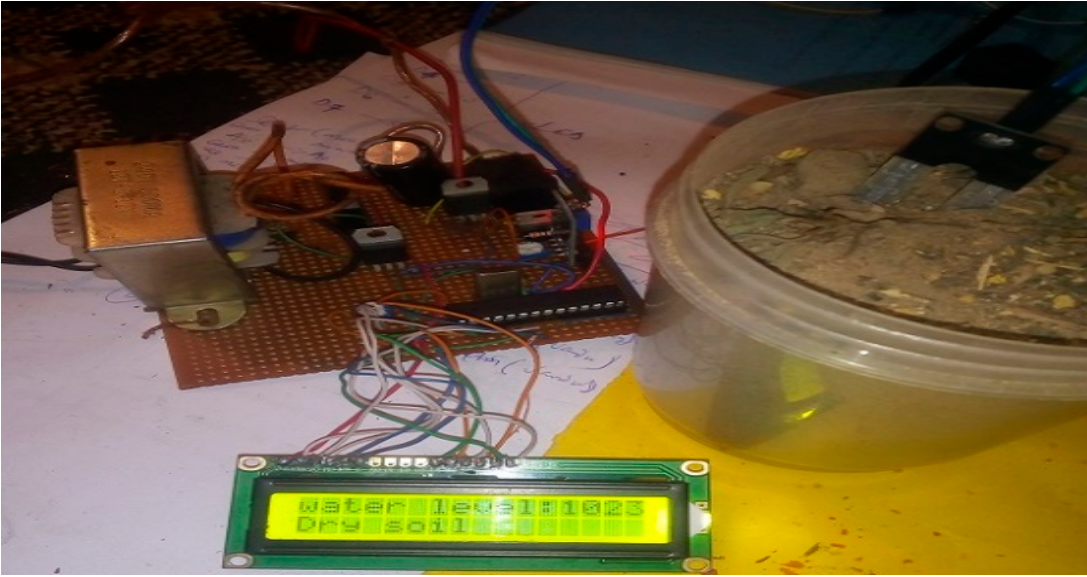
Figure 7. Low-cost sensor interface for IoT-based irrigation system sensor probe inserted in completely dry soil.